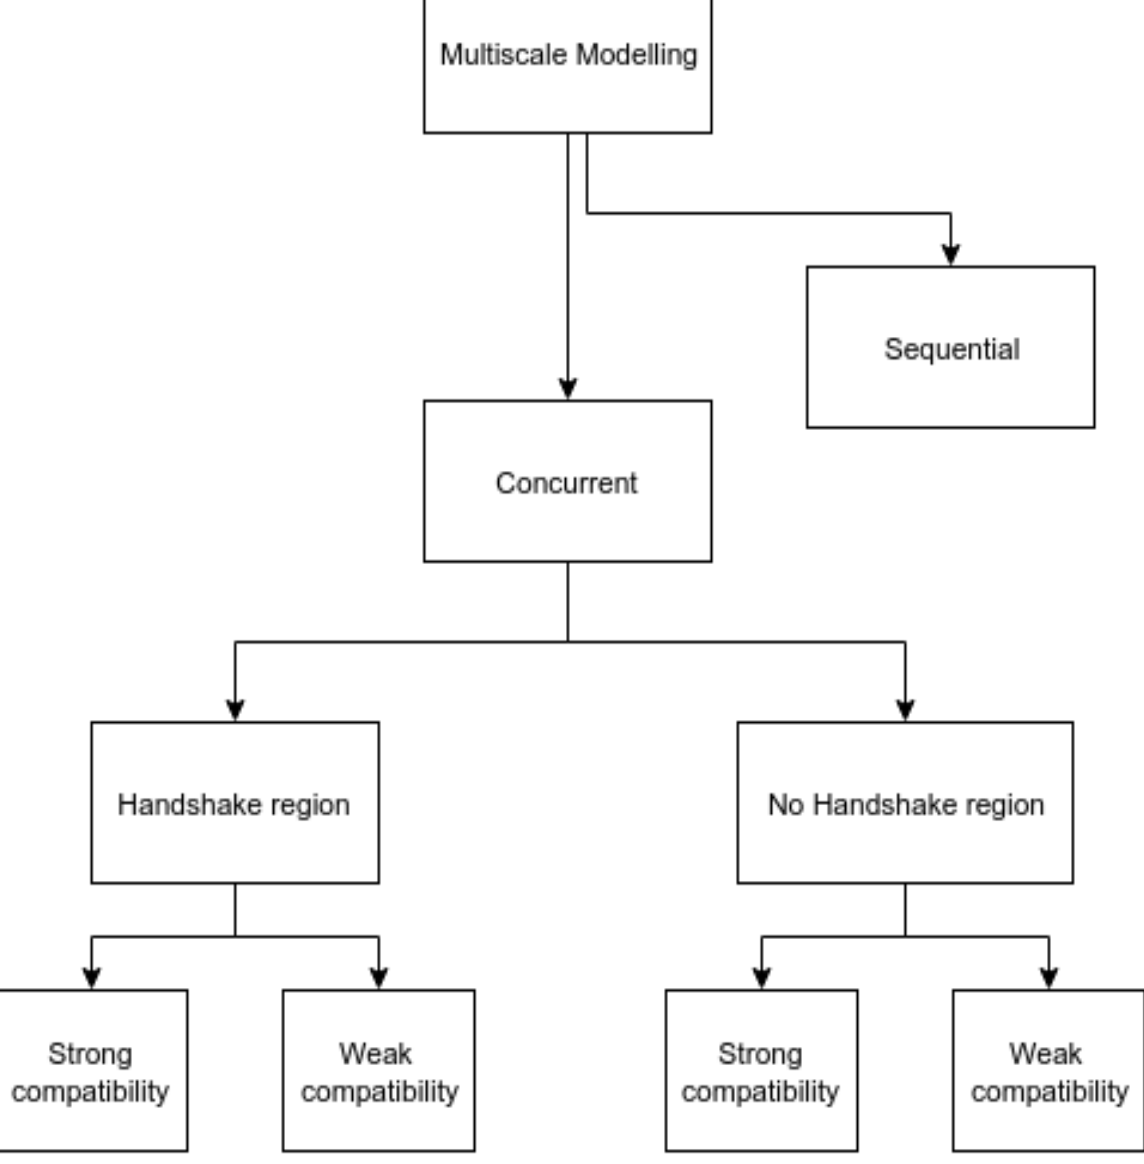
Figure 1. Classification of multi-scale models.